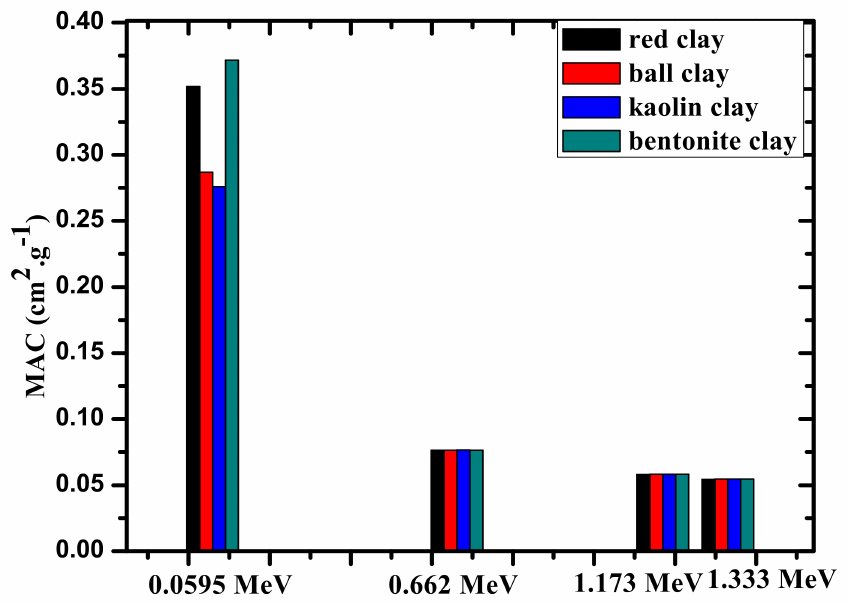
Figure 4. The experimental MAC values for the four investigated clay samples at four selected energies.